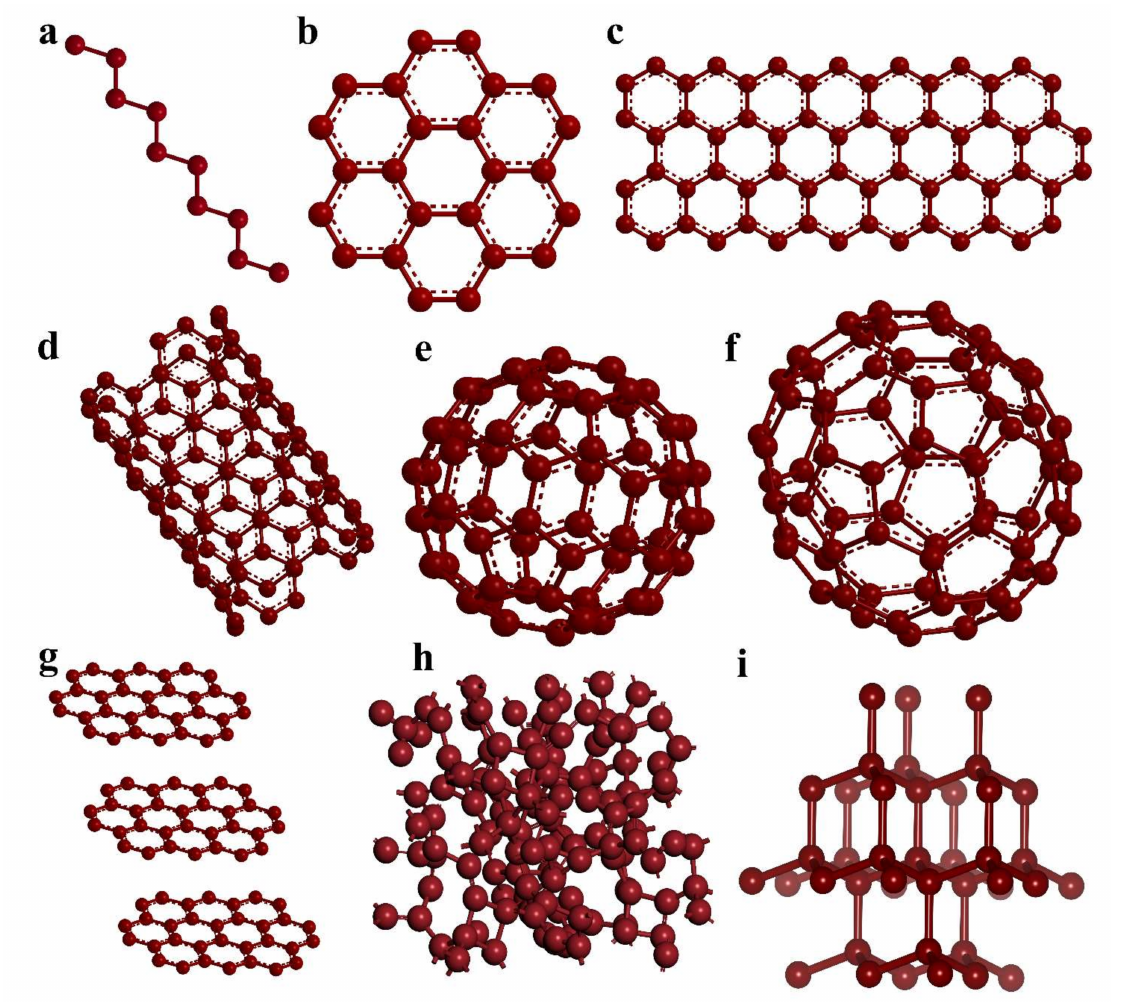
Figure 1. Structure of various carbon allotropes: ( a ) carbon chains; ( b ) polycyclic aromatic hydrocar- bon; ( c ) graphene; ( d ) carbon nanotube (CNT); ( e ) C60; ( f ) C70; ( g ) graphite; ( h ) amorphous carbon; and ( i )